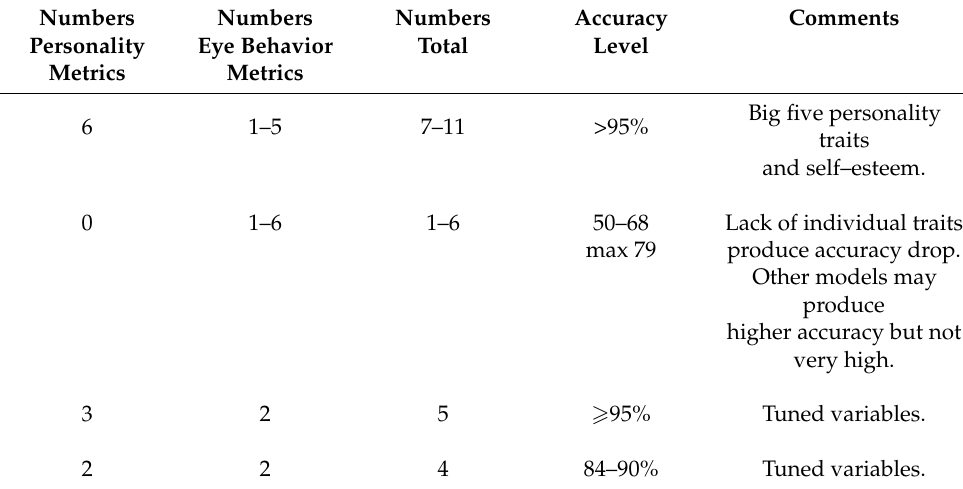
Table 3. Testing numbers of model variables.